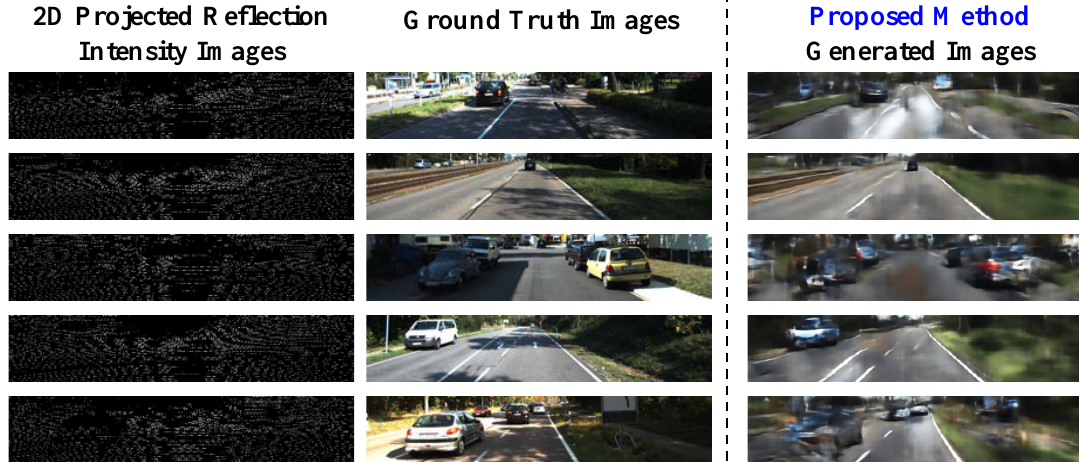
Figure 9. Additional inference examples of GT images with heavy